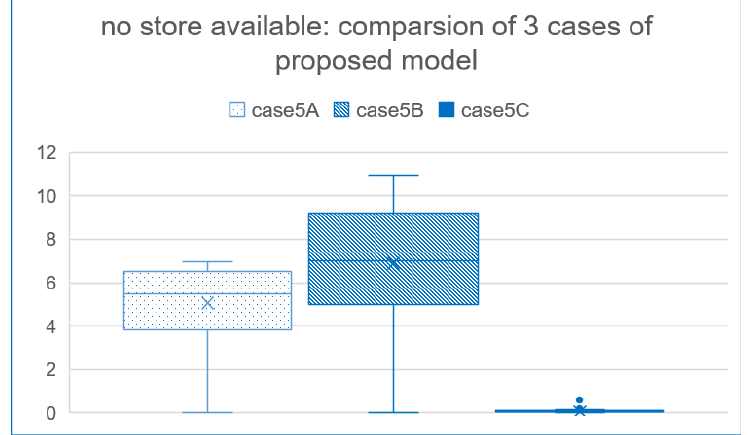
Figure 12. Simulation Results: The comparison of 5A, 5B, and 5C cases for the, no store available